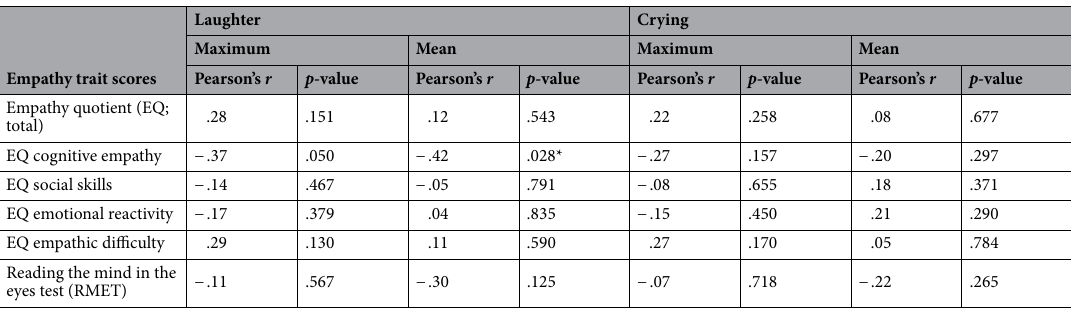
Table 2. Pearson’s r and p -values for the correlations between pupil size measures (collapsed across all time windows) and trait empathy scores (Empathy Quotient, and its subscales, and reading the Mind in the Eyes Test scores), in each emotion separately. Statistical significance level: * p <